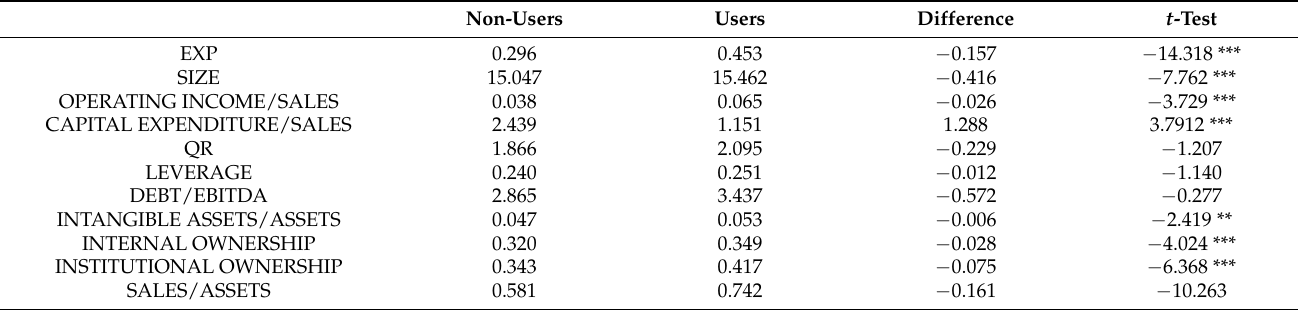
Table 2. T-test of